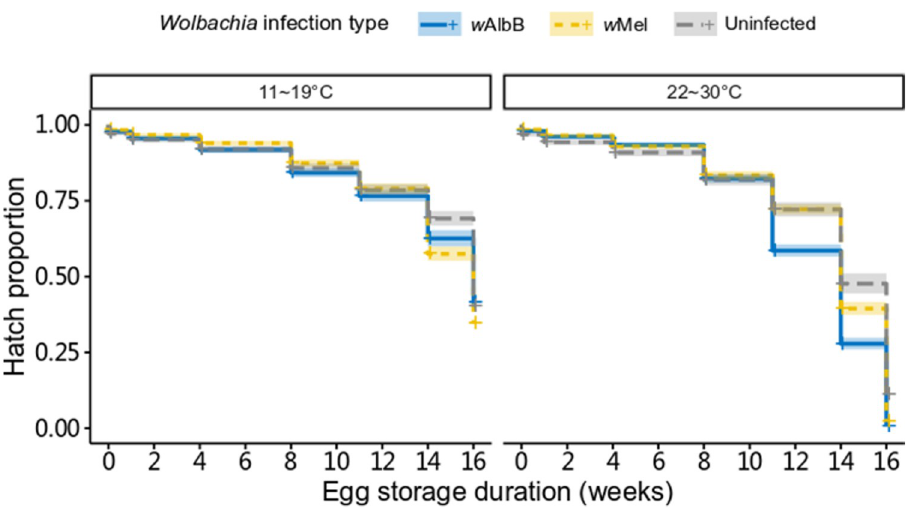
Fig 1. Quiescent egg viability depends on Wolbachia infection type and storage temperature. Survival of eggs based on hatch proportions of uninfected, w Mel-infected and w AlbB-infected Aedes aegypti eggs stored under cycling temperatures of 11–19˚C or 22–30˚C for 0, 1, 4, 8, 11, 14 or 16 weeks. Shaded areas represent 95% confidence intervals.